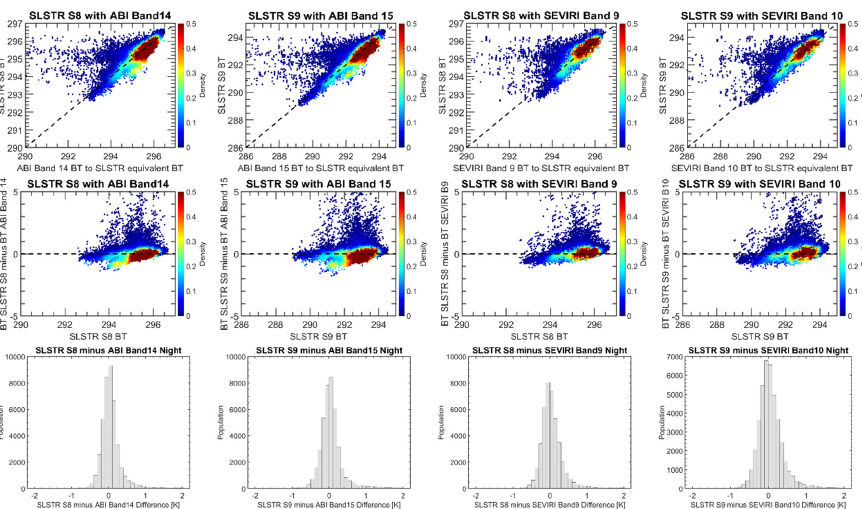
Figure 16. First row: distributions of the daytime BT difference between SLSTR and ABI in the cross ‐ covered region on 27 November 2019, 12:09 UTC. The color indicates the SLSTR minus SEVIRI equivalent BT. Second row: corresponding BT difference distributions between SLSTR and SEVIRI.